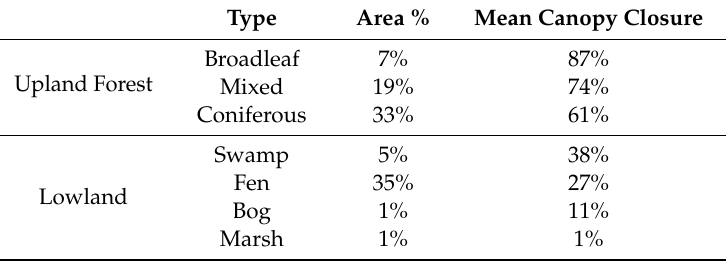
Table 1. Mean canopy closure on vegetated portions of the study area (averaged stands within the 4300-hectare area). Uplands are divided into forest stand types [24] and lowlands into wetland classes [25].